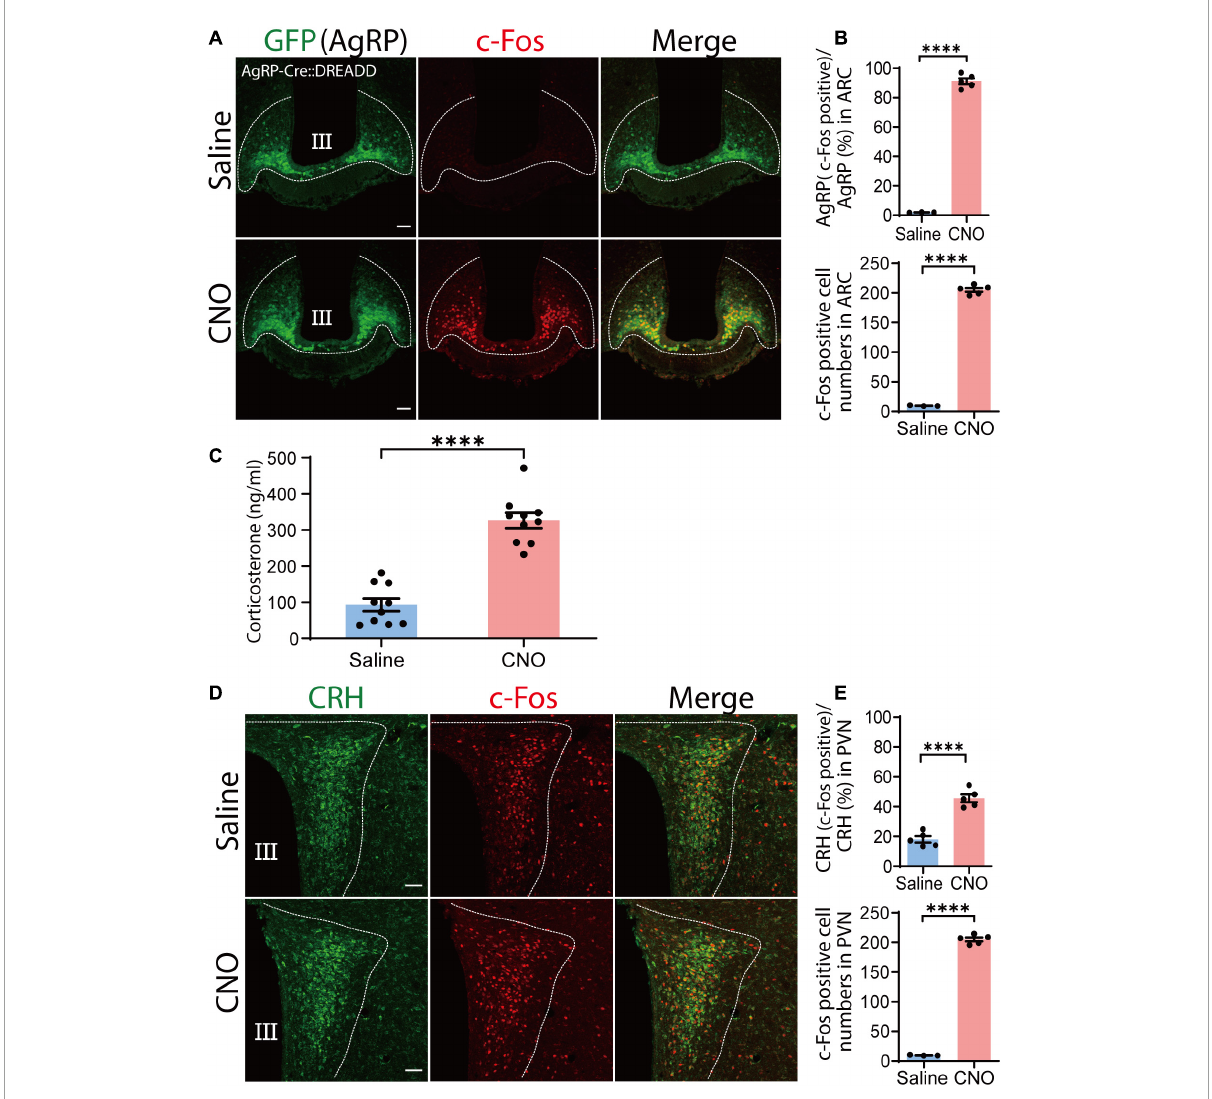
FIGURE2 Chemogenetic activation of agouti-related peptide (AgRP) neurons by clozapine N-oxide (CNO) causes corticotropin-releasing hormone (CRH) neuronal somatic activation and increased serum corticosterone levels. (A) Injection of CNO i.p. induced c-Fos expression in the arcuate nucleus (ARC). Confocal image showing AgRP neurons stained with an anti-GFP antibody (green) and anti-c-Fos antibody (red). Scale bars, 50 µ m. (B) Percentage of AgRP neurons expressing c-Fos in the ARC in upper panel; and total numbers of c-Fos-positive cells in the ARC in lower pannel; **** P < 0.0001, unpaired Student’s t test. (C) Serum corticosterone level 1 h after CNO and saline injection; **** P < 0.0001, unpaired Student’s t test. (D) Confocal image showing c-Fos expression in CRH neurons stained with an anti-CRH antibody (green) in the paraventricular nucleus (PVN) area after CNO and saline injection. Scale bars, 50 µ m. (E) Proportion of CRH and c-Fos colocalization in the PVN (upper panel) . In total, 86.76 ± 3 CRH cells colocalized with c-Fos out of a total of 192 ± 3 CRH cells; **** P < 0.0001, unpaired Student’s t test. Quantification of total c-Fos expression in the PVN; **** P < 0.0001, unpaired Student’s t test (lower panel) . Error bars represent SEM. Dotted line indicate the area for counting of AgRP, CRH and c-Fos positive